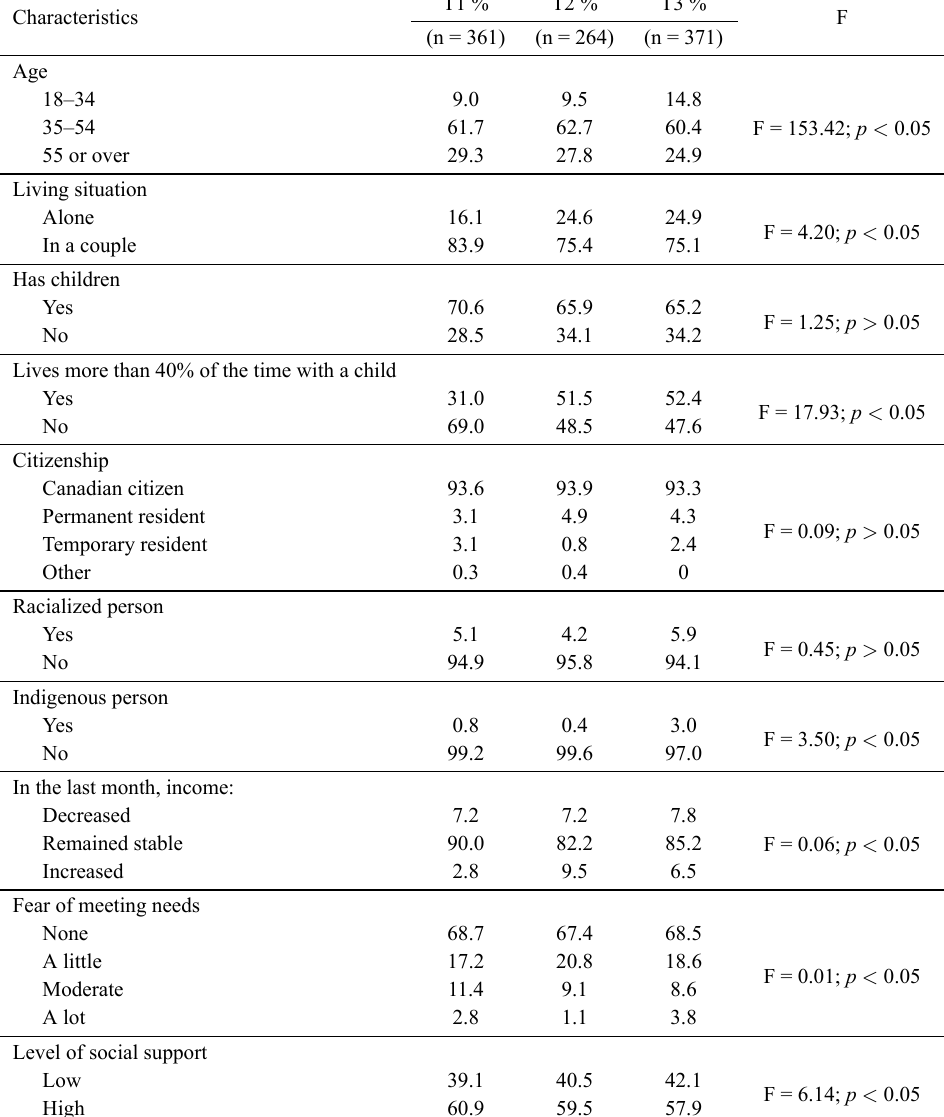
Table 1. Sociodemographic characteristics of the